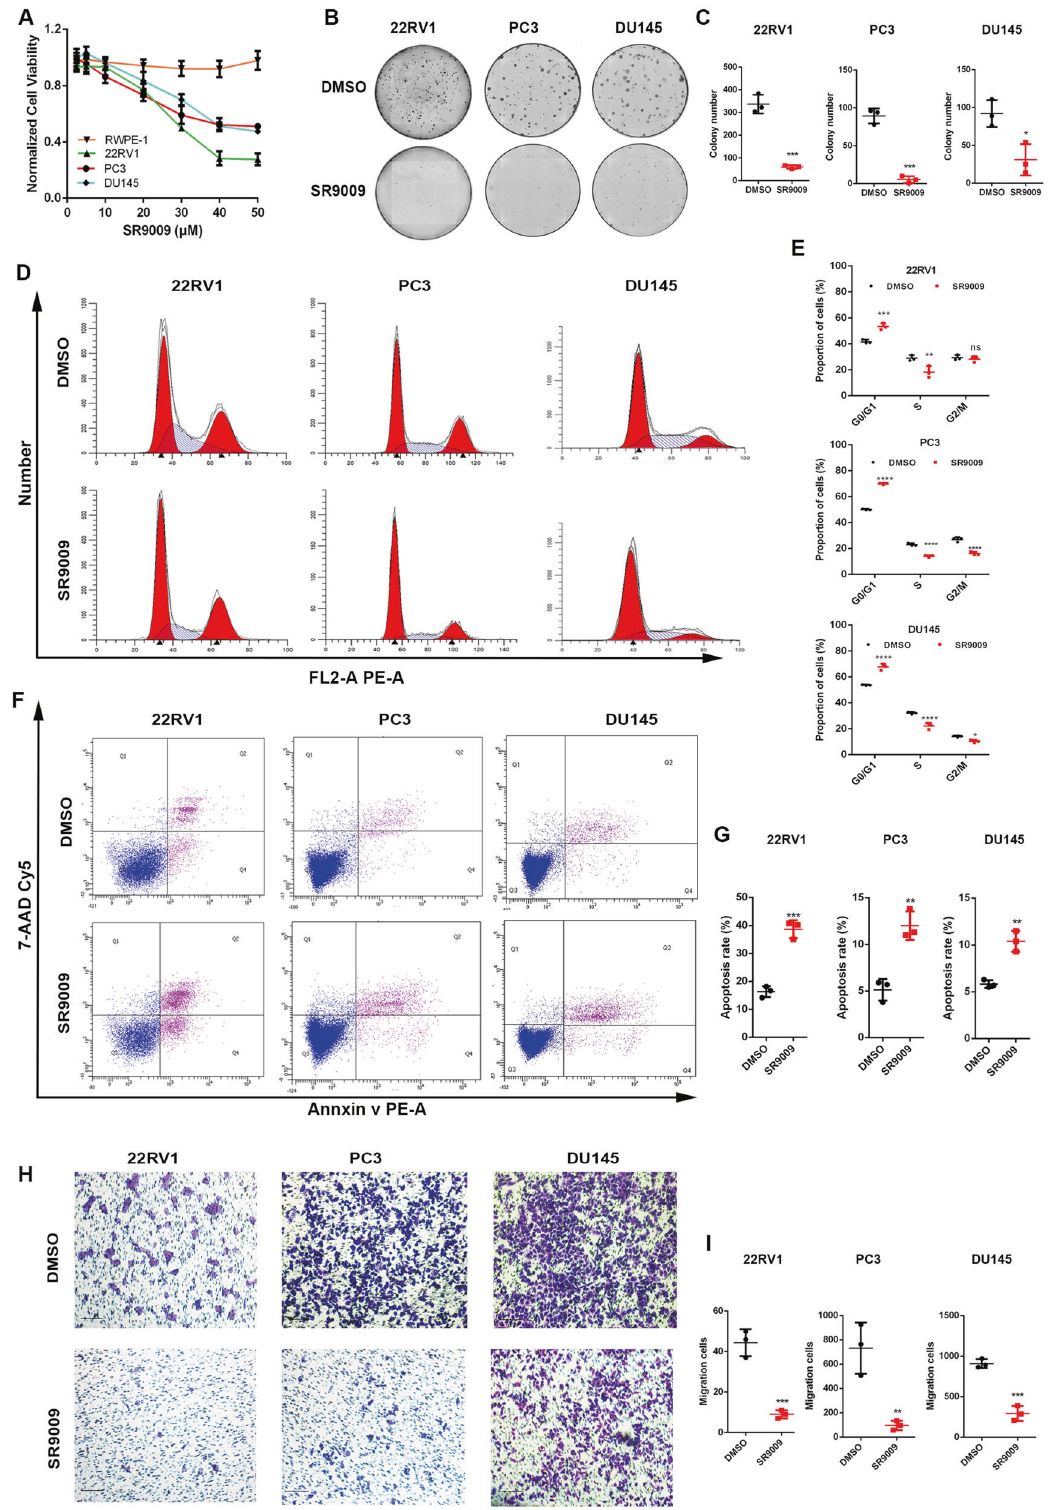
Fig. 1 SR9009 is selectively lethal in PCa cells. A CCK-8 assay of RWPE-1, PC3, 22RV1, and DU145 cell lines treated with different concentrations of SR9009 for 48 h; means ± SDs; unpaired t test. B , C Clone formation assay of PC3, 22RV1, and DU145 cell lines treated with DMSO or SR9009 (20 μ M) for 7 – 14 days; n = 3; means ± SDs; unpaired t test. D , E Cell cycle tests of PC3, 22RV1, and DU145 cells treated with DMSO or SR9009 (20 μ M) for 48 h; n = 3; means ± SDs; ANOVA. F , G Cell apoptosis tests of PC3, 22RV1, and DU145 cells treated with DMSO or SR9009 (20 μ M) for 48 h; n = 3; means ± SDs; unpaired t test. H , I Transwell migration assays of PC3, 22RV1, and DU145 cells treated with DMSO or SR9009 (20 μ M) for 48 h; n = 3; means ± SDs; unpaired t test. ns, not signi fi cant; * p < 0.05; ** p < 0.01; *** p < 0.001; **** p < 0.0001. Cell Death and Disease (2022)